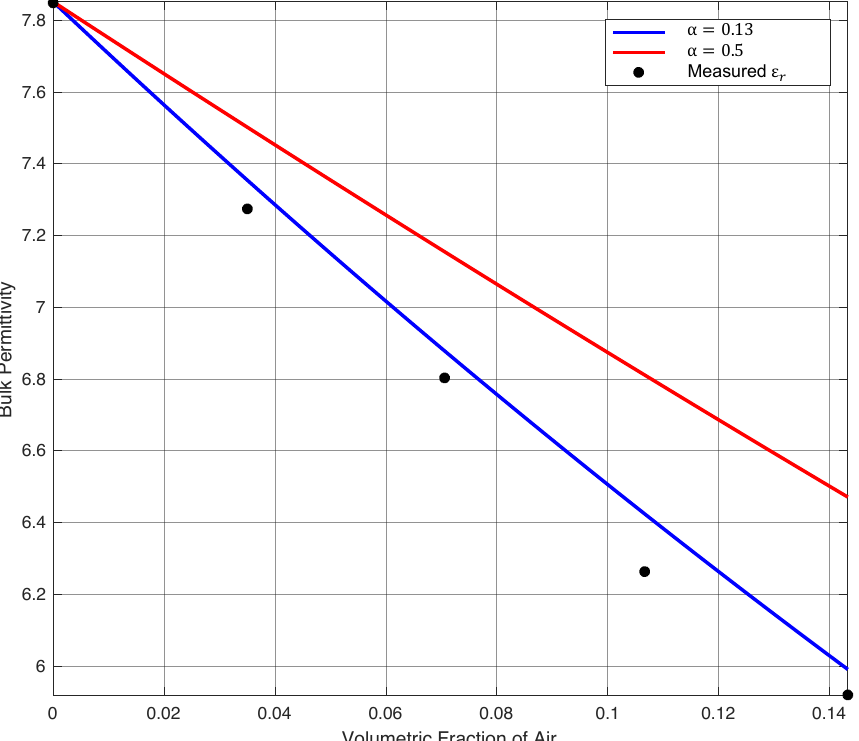
Figure 8. The measured and the calculated bulk permittivity using α = 0.5 and α = 0.13. It is apparent that the revised shape factor α = 0.13 over-performs the default α =